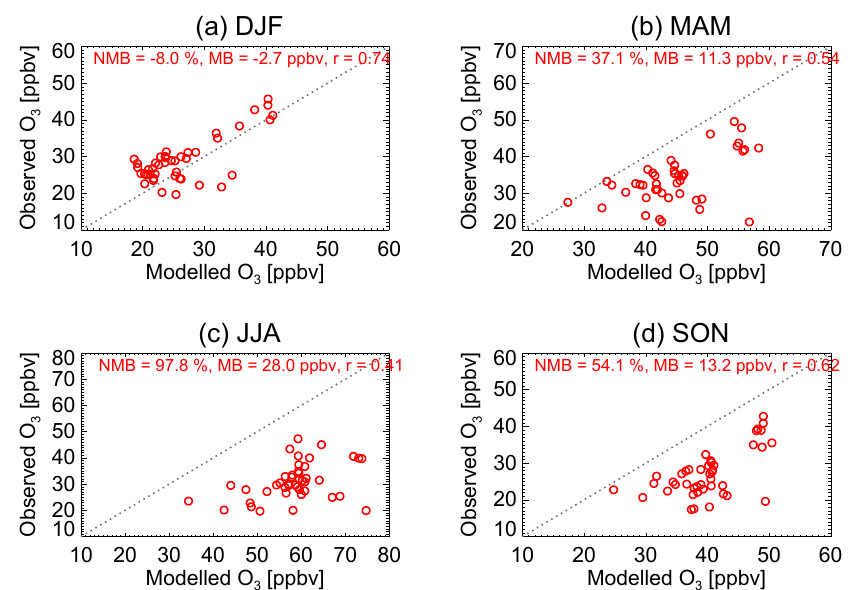
Figure 9. Scatter plots of seasonal mean observed and simulated 2008 O 3 concentrations (ppbv) at CASTNET EPA monitoring stations located in North